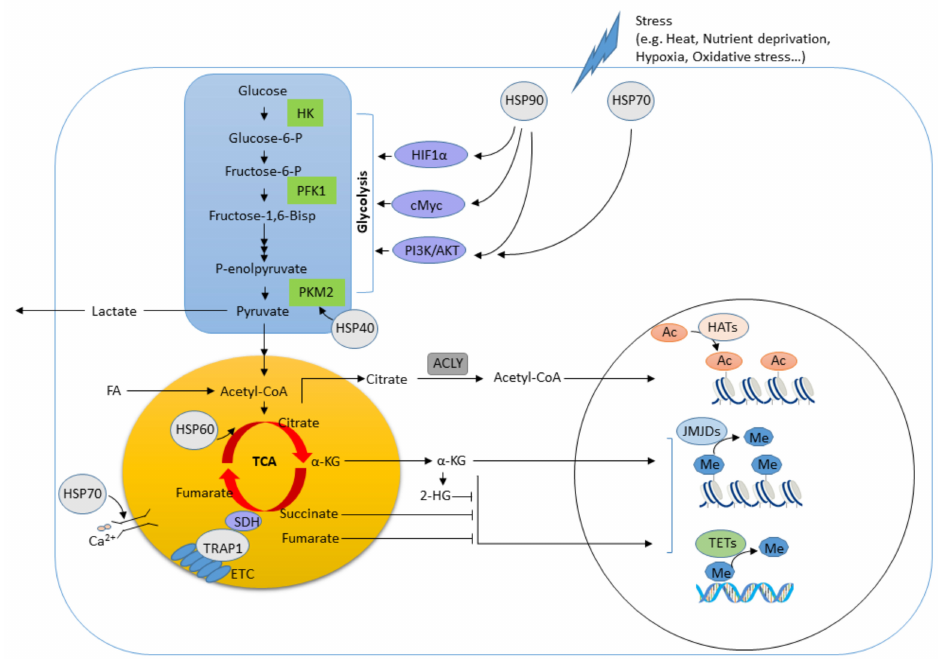
Figure 1. The regulation of molecular chaperones in metabolic pathways and epigenetic modifications. Heat shock proteins (HSPs) can interact with the signaling of HIF1 α , cMyc, PI3K / AKT and / or modulate the activity of metabolic enzymes (i.e., HK, PFK1, PKM2 and SDH) to regulate metabolic pathways. The production of metabolites such as acetyl-CoA, α -KG, succinate and fumarate are linked to the function of HATs, JMJDs and TETs involved in epigenetic modification. 2-HG, 2-Hydroxyglutarate; AC,acetylation; ACLY,ATPcitratelyase; α -KG, α -ketoglutarate;